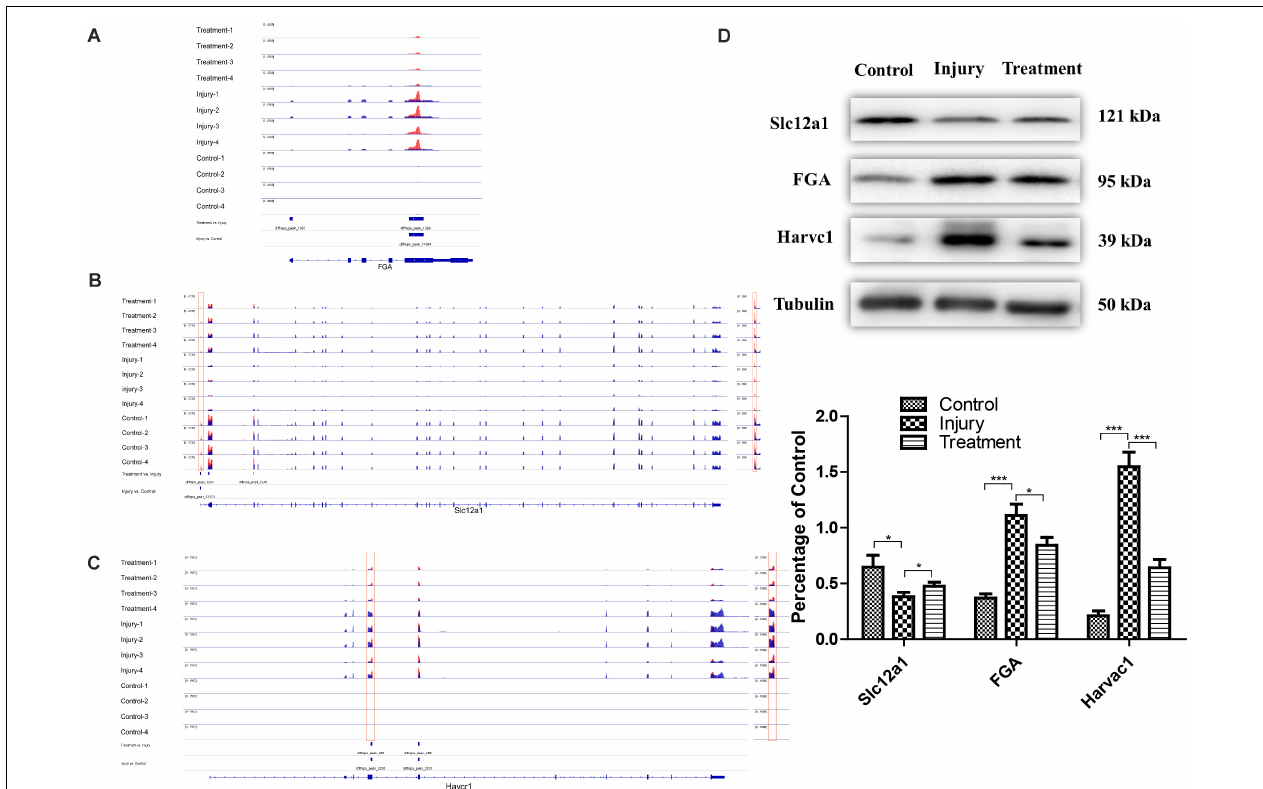
FIGURE 8 | Representative genes with opposite m6A methylation and expression trends between IvC and TvI. (A) Visualization of m6A-modified genes FGA in the control group, injury group, and treatment group. (B) Visualization of m6A modified genes Slc12a1 in the control group, injury group, and treatment group. (C) Visualization of m6A-modified genes Havcr1 in the control group, injury group, and treatment group. (D) Western blot images of FGA, Slc12a1, and Havcr1 in control group, injury group, and Havcr1 group. Error bars represent the standard deviation. * p < 0.05, *** p < 0.001, Student’s t